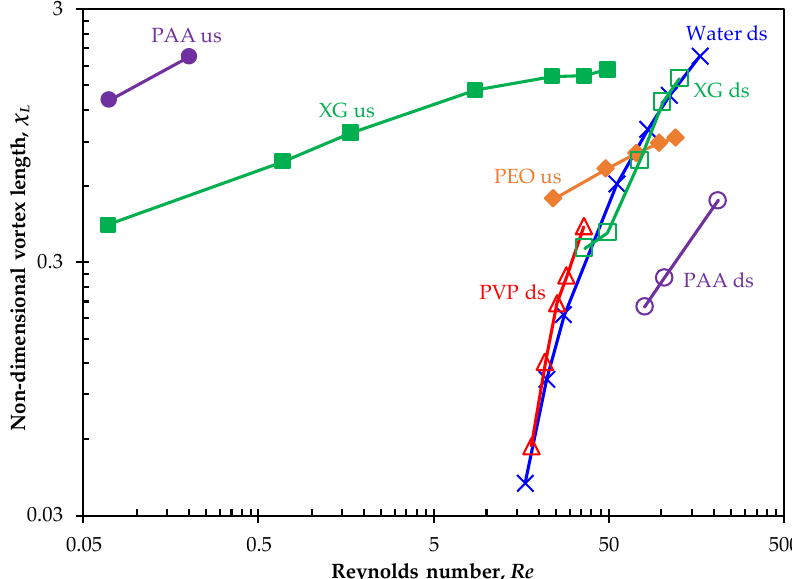
Figure 11. Non-dimensional vortex length, χ L = L v / w , against the Reynolds number in the flow of Newtonian and non-Newtonian fluids through a contraction–expansion microchannel. Filled markers are for the upstream (us) vortices at the contraction part and hollow markers are for the downstream (ds) vortices at the expansion part of the microchannel. Note that only the size of stable vortex (either symmetric or asymmetric) is shown in the plot.